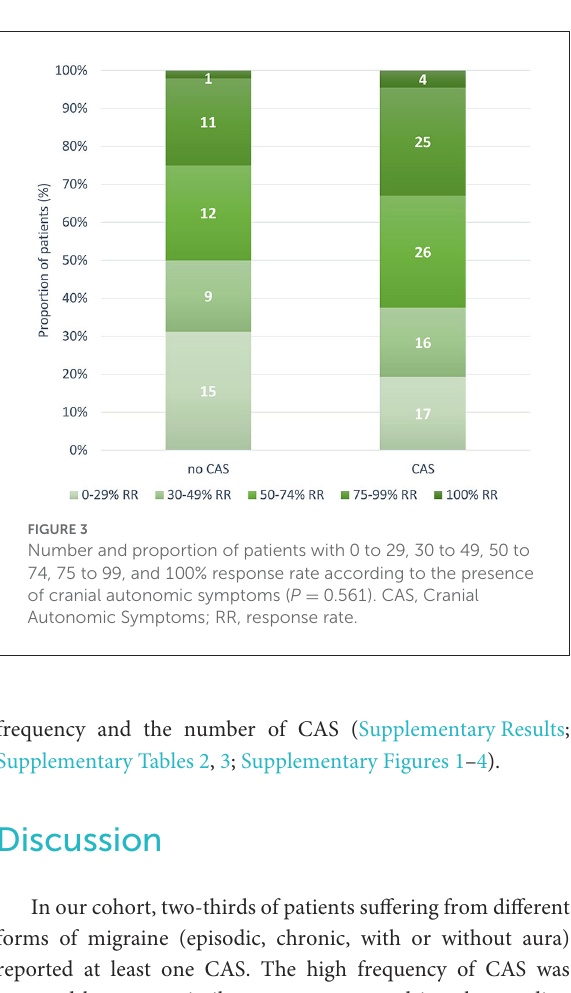
frequency and the number of CAS (Supplementary